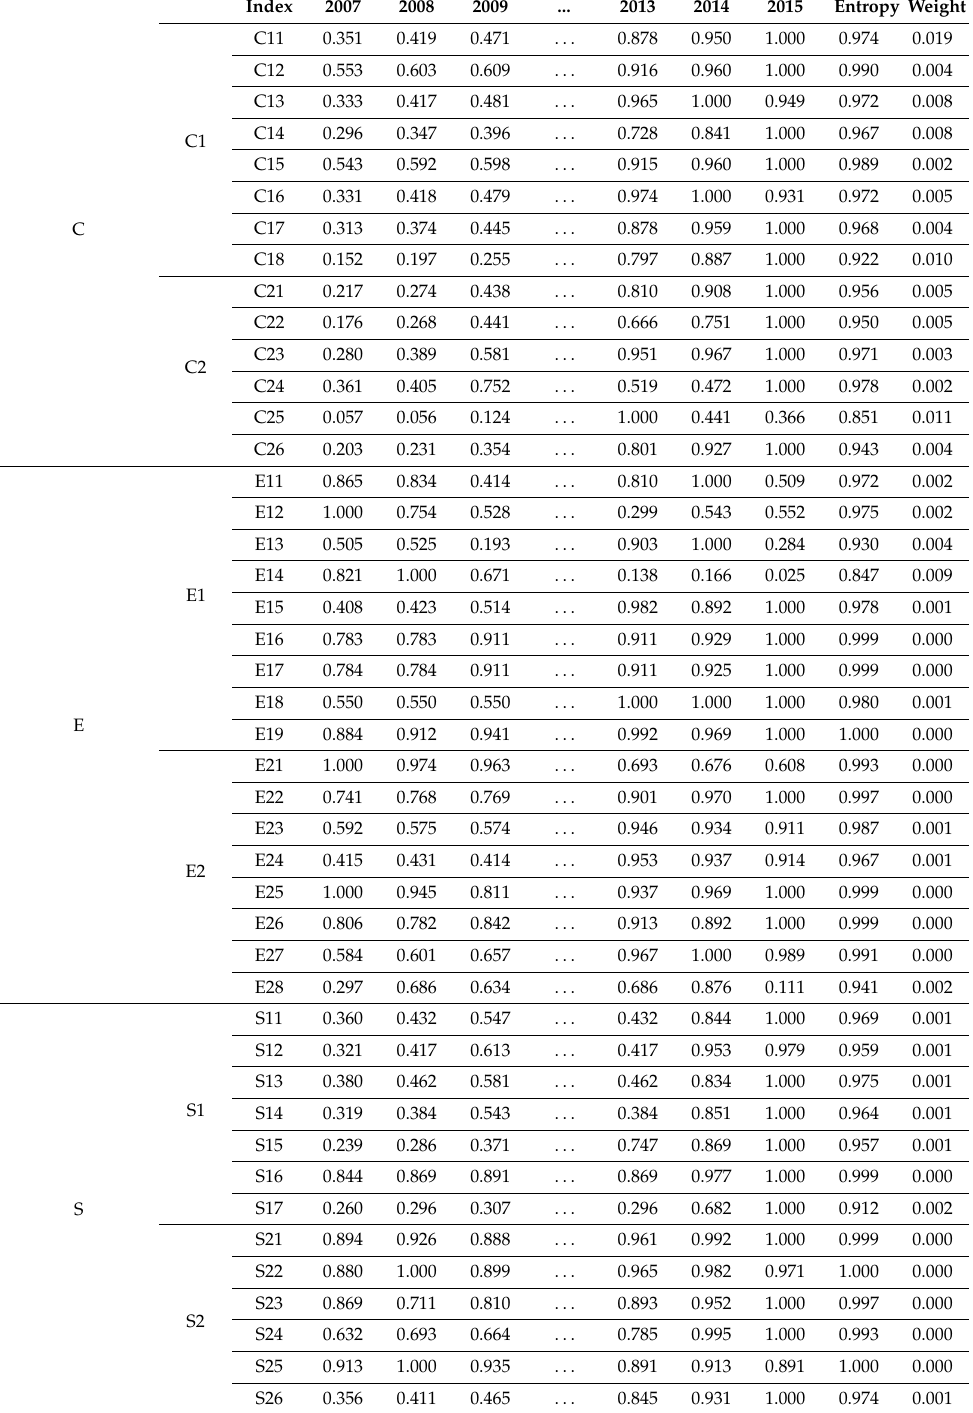
Table 3. Data standardization and processed results for information